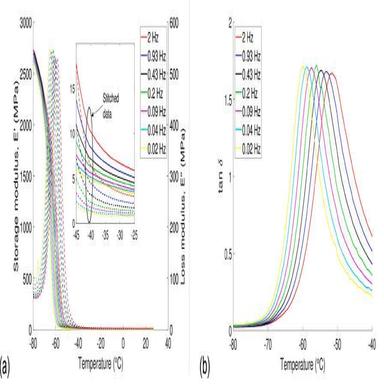
DMA results for U-NR: (a) temperature dependent storage (solid line) and loss (dashed line) moduli, and (b) loss tangents.